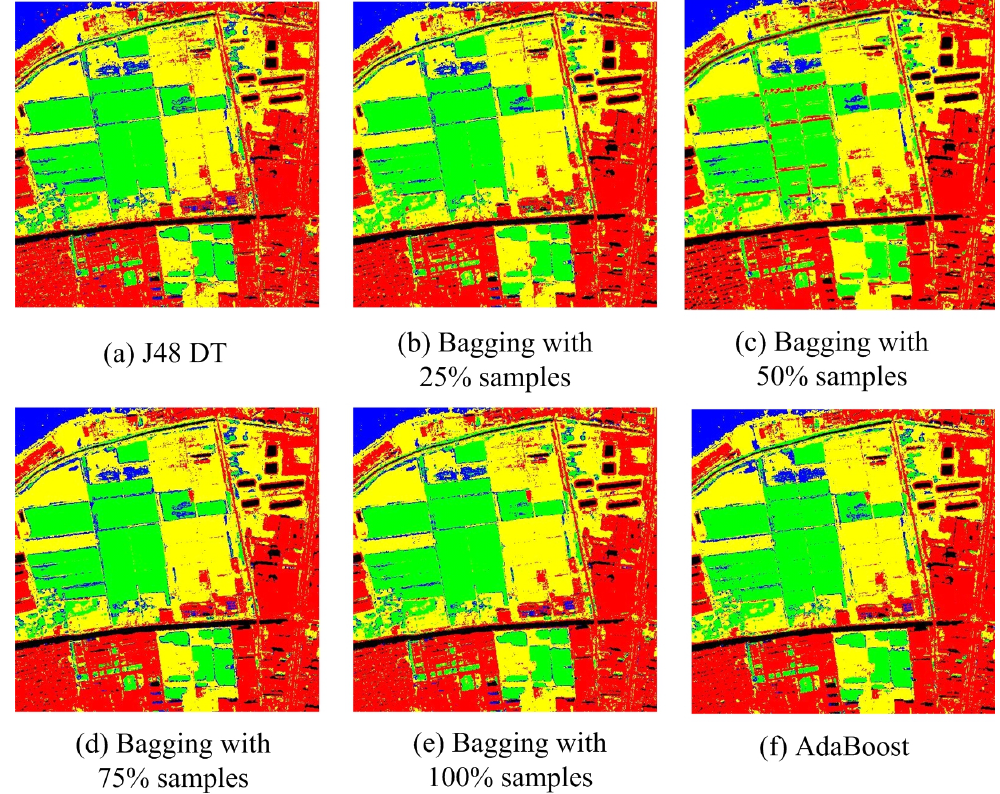
Figure 7. Classifications of J48 DTC Based on Bagging and AdaBoost.